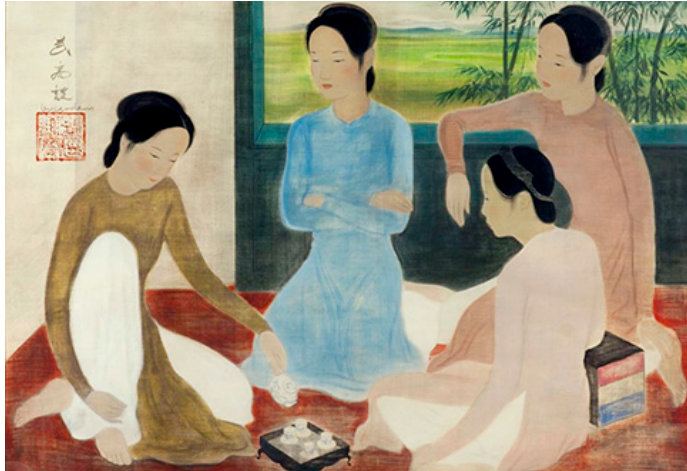
Figure 10. Thieu nu uong tra —Vu Cao Dam (real). Exhibited at Cernuschi museum, September 2012–January 2013. The image was sourced from The Thao & Van Hoa Newspaper (Bay 2016b).